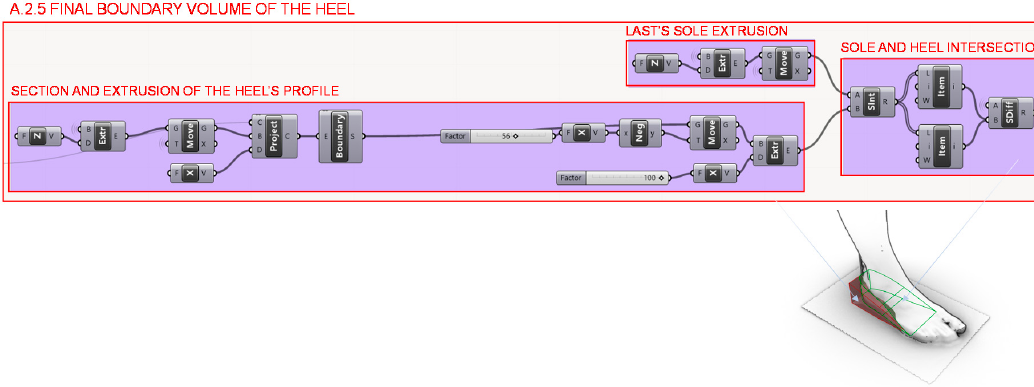
Figure 12. Programming structure definition developed to determine the heel profile.